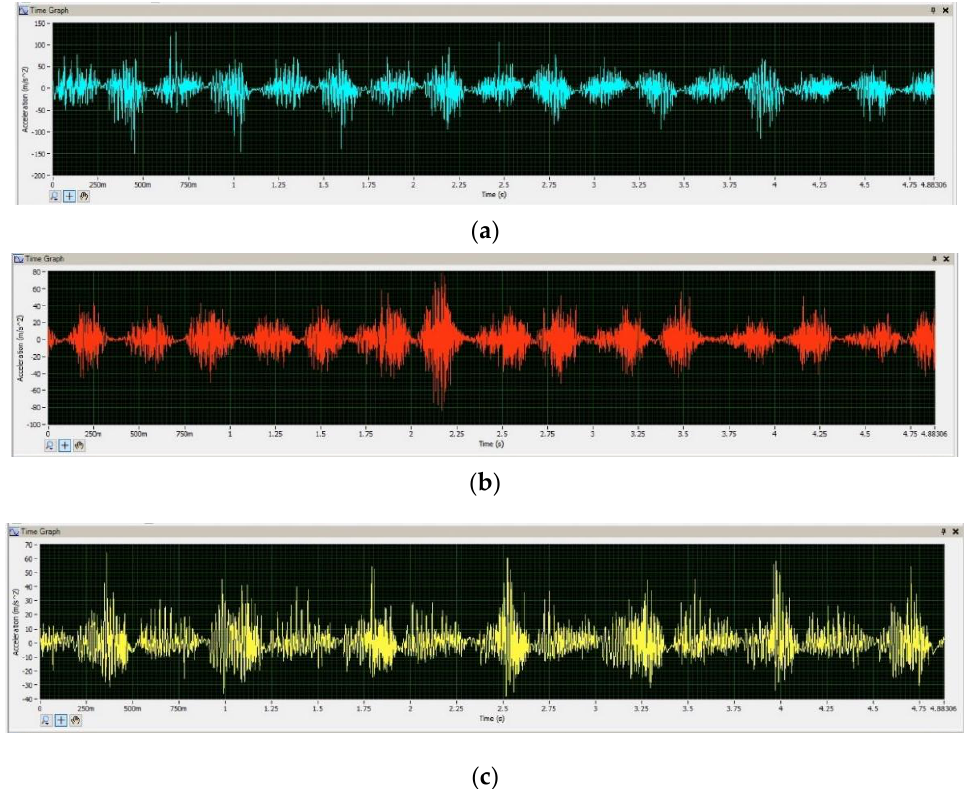
Figure 7. Vibrations ( a ) on axis x-longitudinal, cyan colour, ( b ) on axis y-transversal, red colour, ( c ) on axis z-vertical, yellow colour.